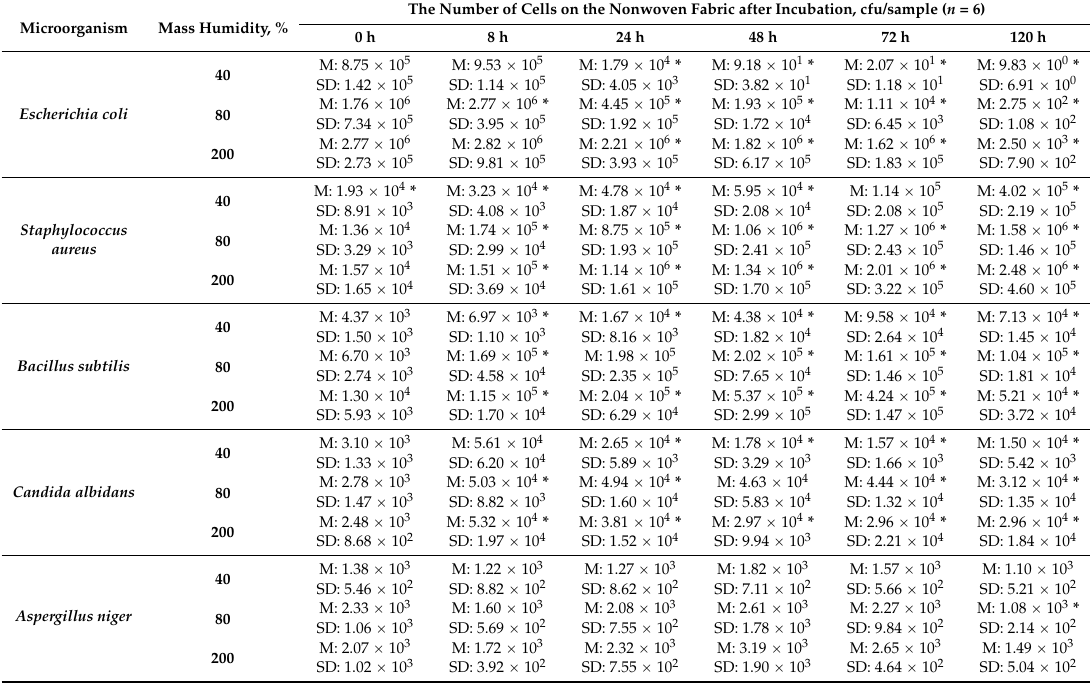
Table 1. The number of microorganisms on filter materials after different time intervals. The Number of Cells on the Nonwoven Fabric after Incubation, cfu/sample ( n = 6) Microorganism Mass Humidity, % 0 h 8 h 24 h 48